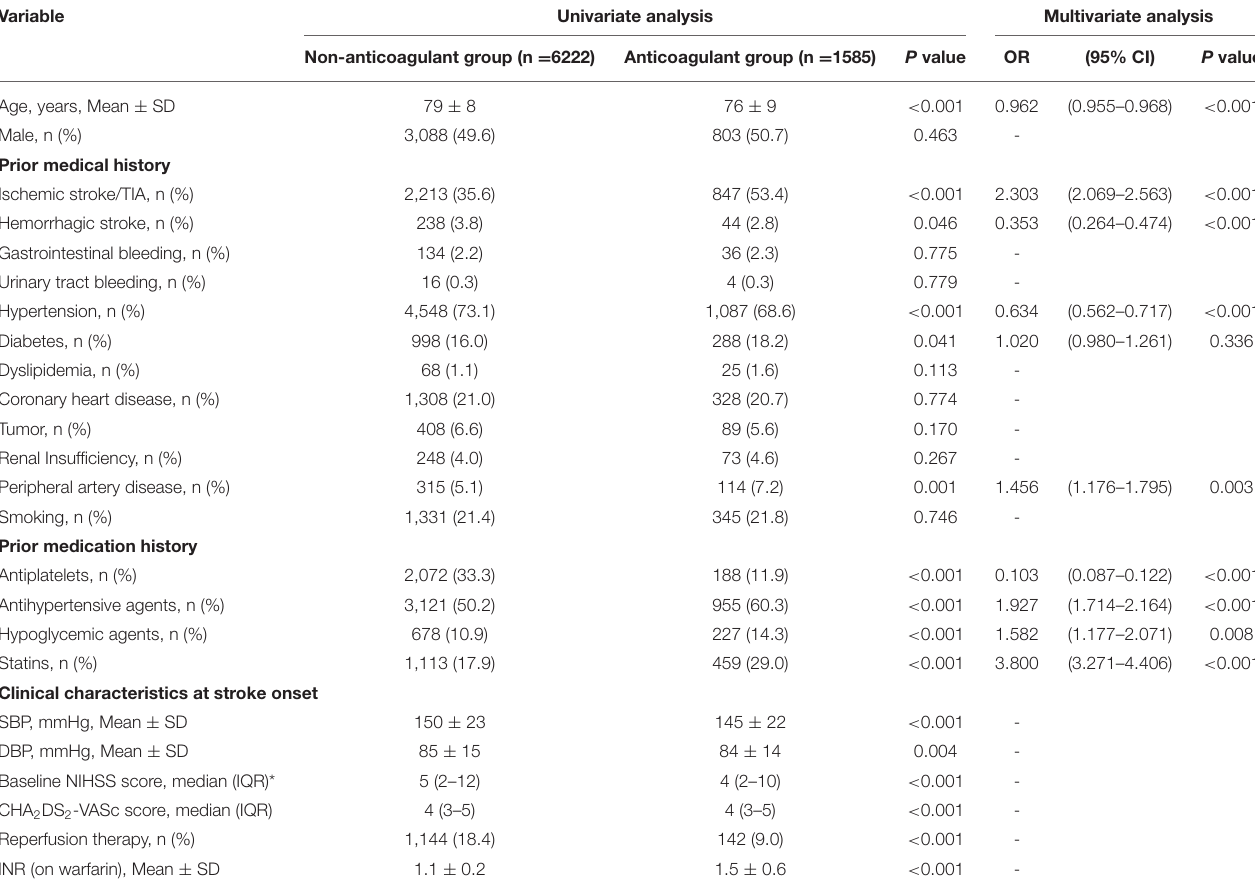
TABLE 4 | Univariate and multivariate analysis for prior use of anticoagulation in patients with previously diagnosed atrial fibrillation (AF) with high risk of stroke. Variable Univariate analysis Multivariate